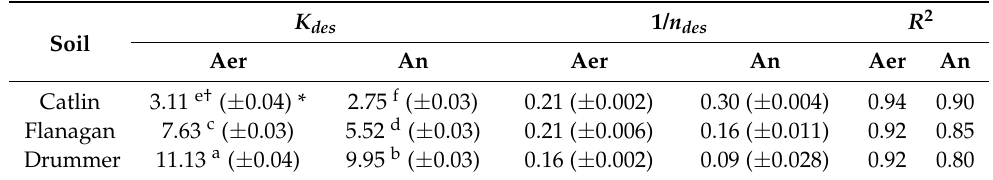
Table 3. Desorption (Freundlich model) of 14 C-metolachlor in different soil types under aerobic (Aer) and anaerobic (An) environmental conditions.